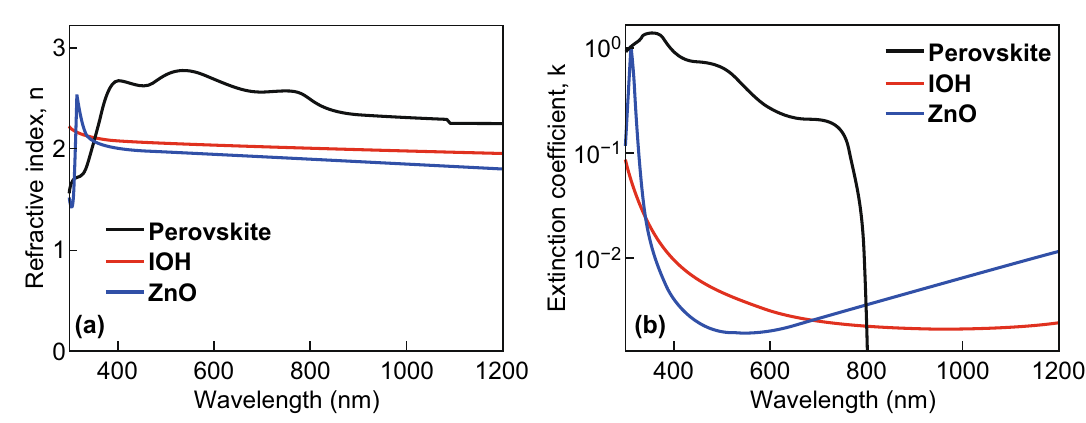
Fig. 9 a Refractive Indices and b Extinction coefficients of Perovskite (CH 3 NH 3 PbI 3 ), IOH, and ZnO materials